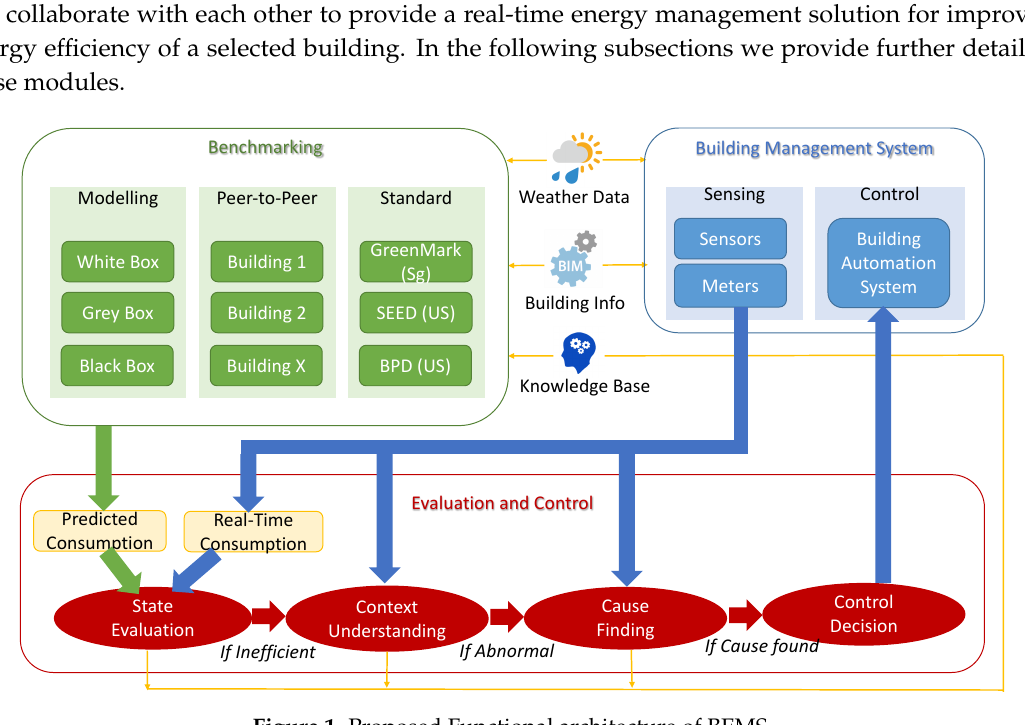
Figure 1. Proposed Functional architecture of